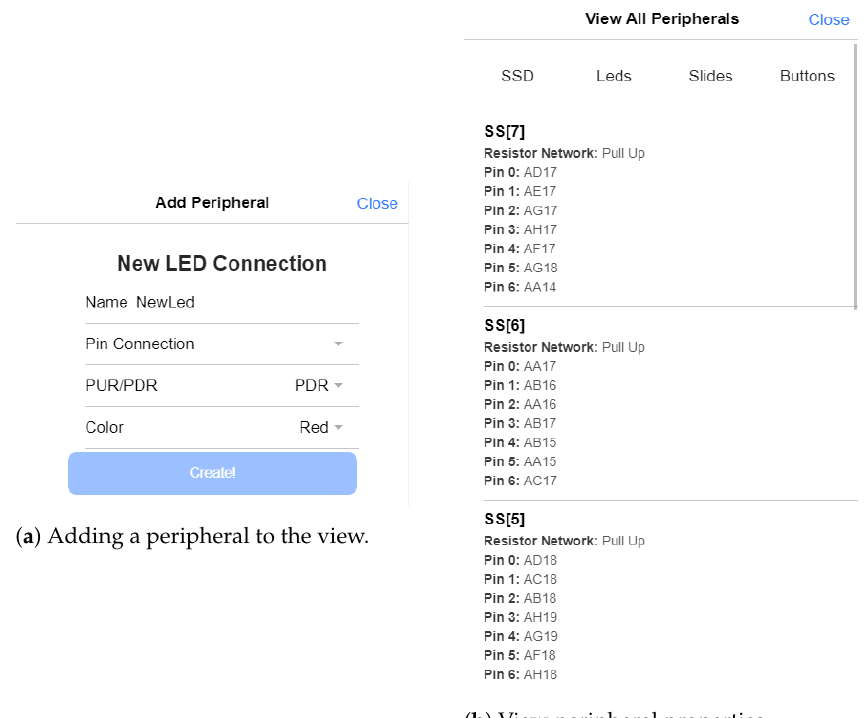
Figure 6. Multiple functionalities of the user application.